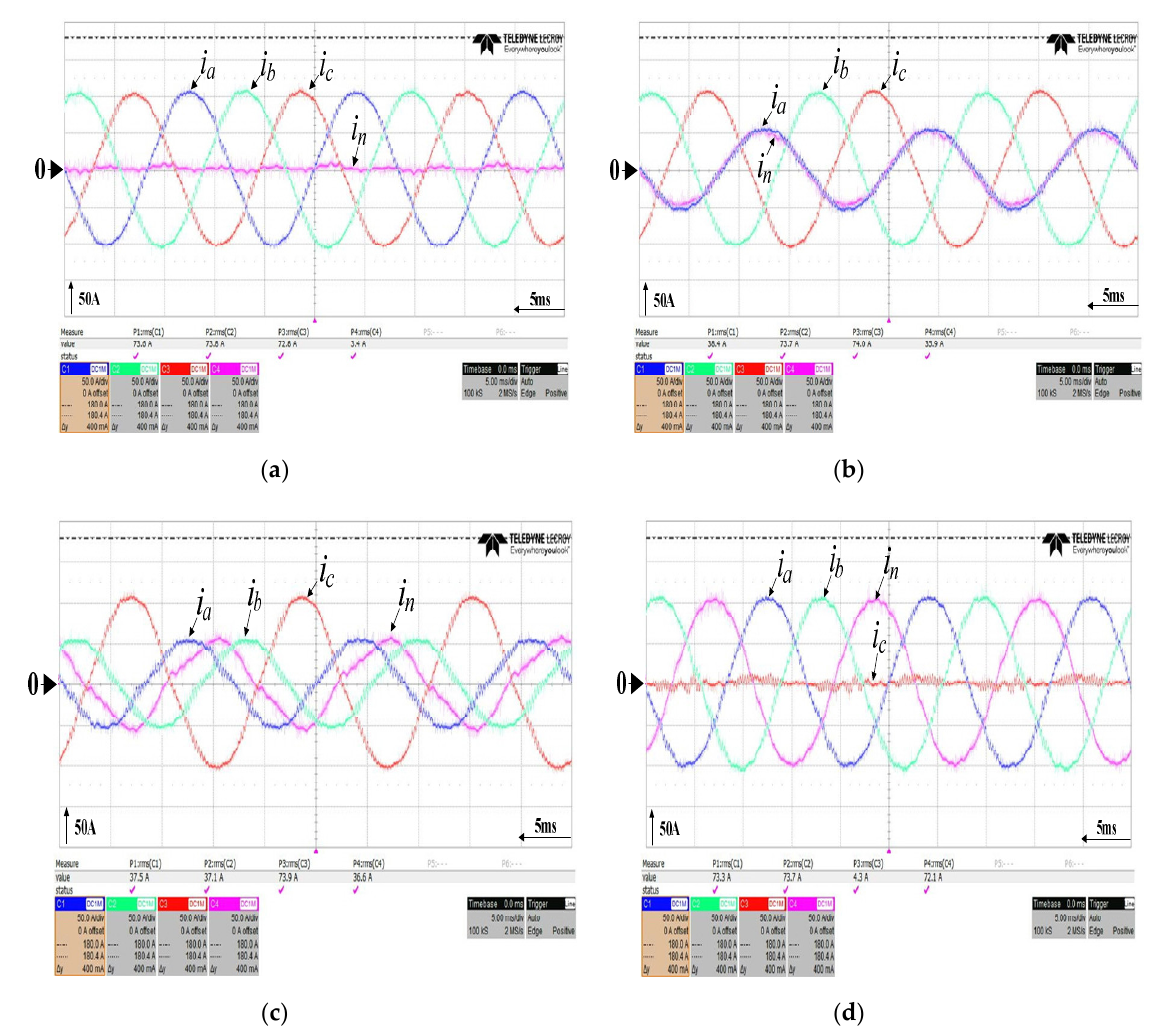
Figure 12. Phase current ( i a , i b , i c ) and neutral current ( i n ) of three-phase 4-leg inverter: ( a ) With three-phase balanced load condition; ( b ) when the load of phase A is half of the phase B and C loads by load imbalance; ( c ) when the load of phase C doubles phases A and B due to load imbalance; ( d ) alternate operation of the additional switch arm due to failure of phase C.